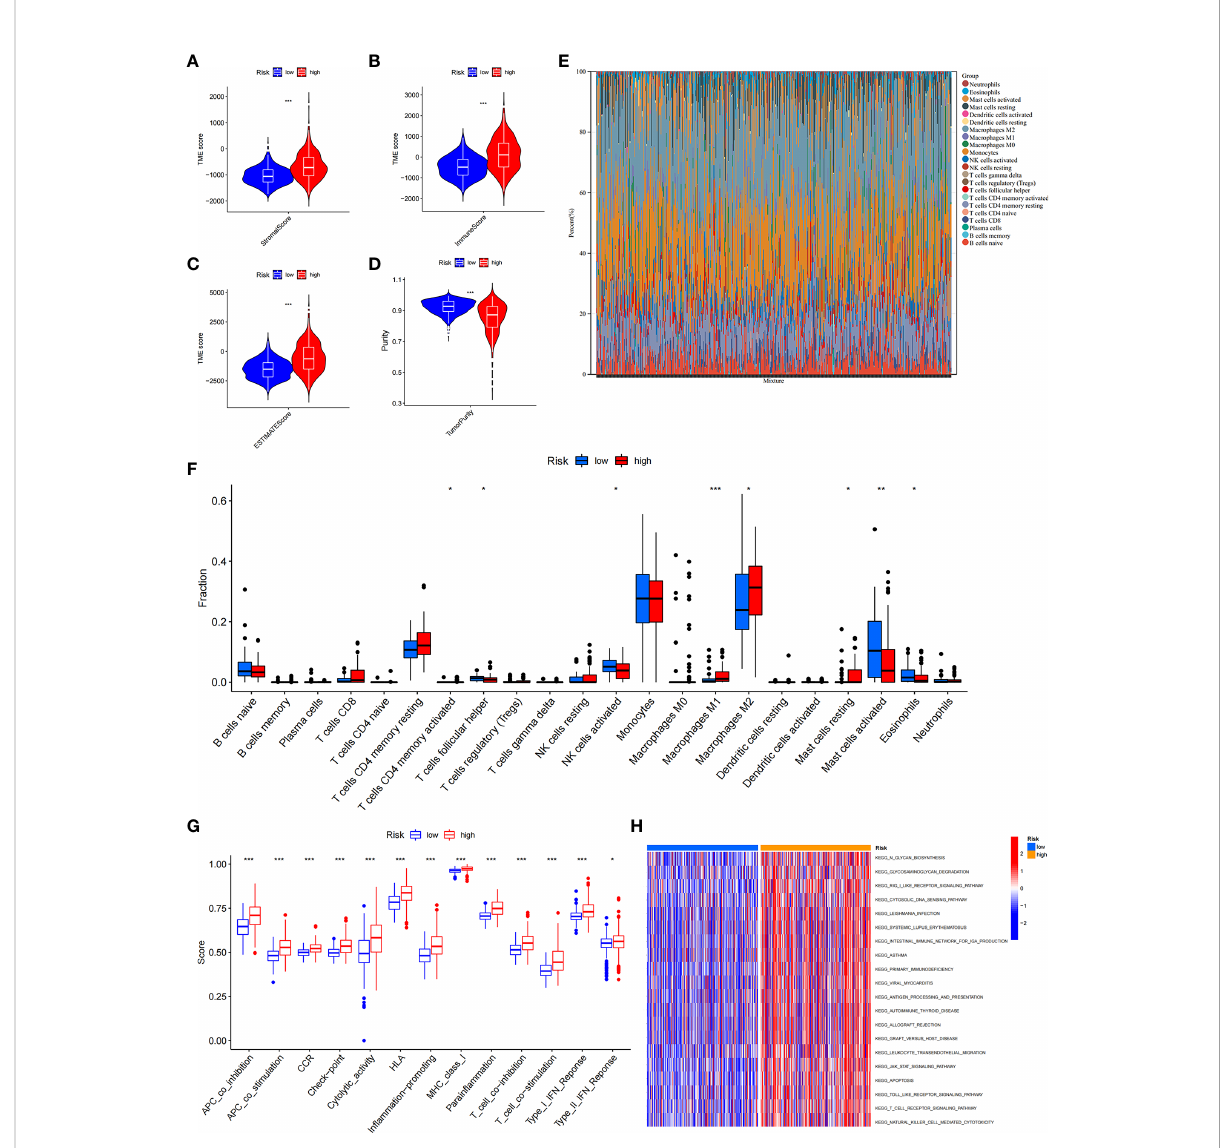
FIGURE 9 The immune landscape of ICD-high- and ICD-low-risk groups. (A – D) Violin plots of the stromal score, immune score, ESTIMATE score, and tumour purity between the ICD-high and ICD-low risk groups. (E) Relative percent of immune in fi ltration in the ICD-high and ICD-low risk groups. (F) Box plot visualizes signi fi cantly different immune cells between the ICD-high and ICD-low risk groups. *P < 0.05, **P< 0.01, ***P < 0.001. (G) Box plots of the difference in known functions related to immune modulation between the ICD-high and ICD-low risk groups. *P